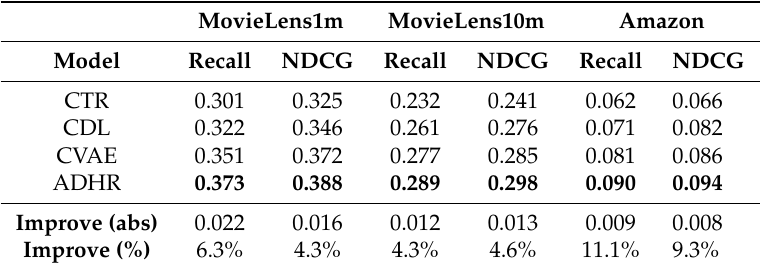
Table 4. Cold-start top-20 recommendation performance of all comparison